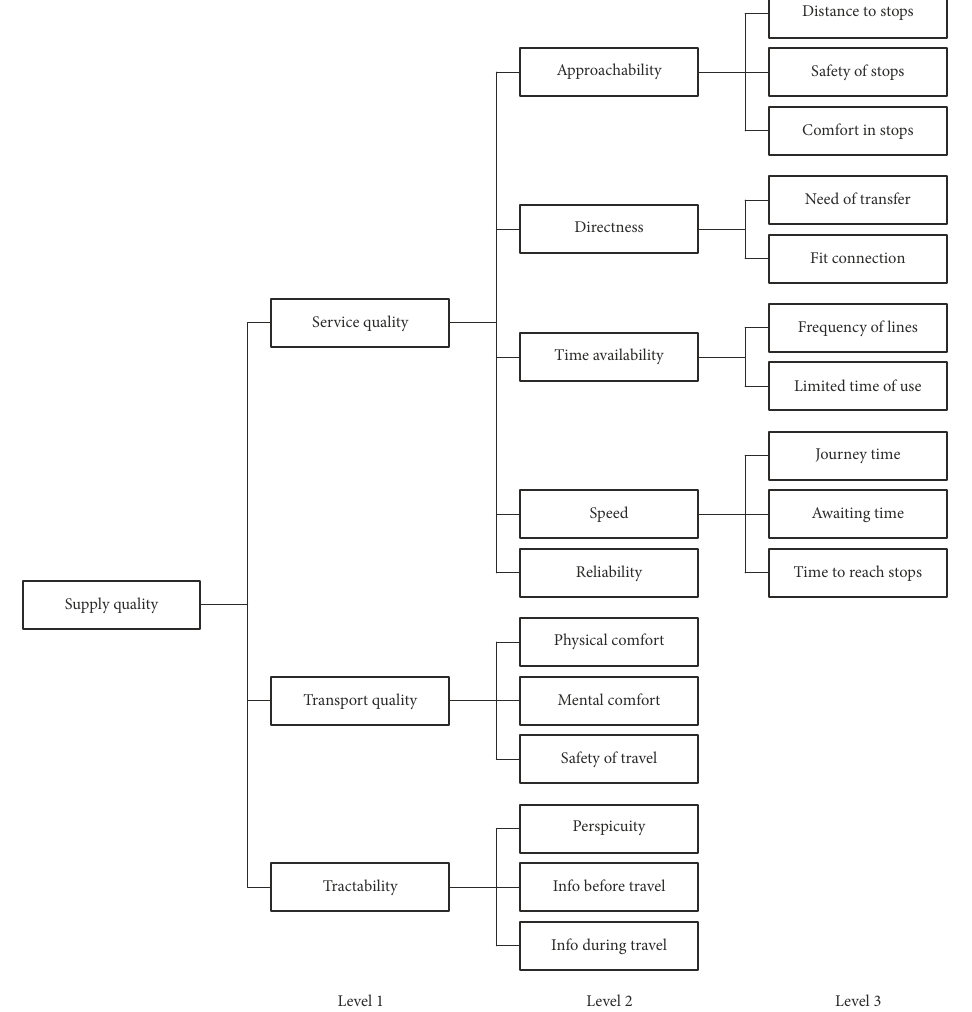
Figure 1. The hierarchical model of public bus transport supply quality (source: research based on Duleba et al.